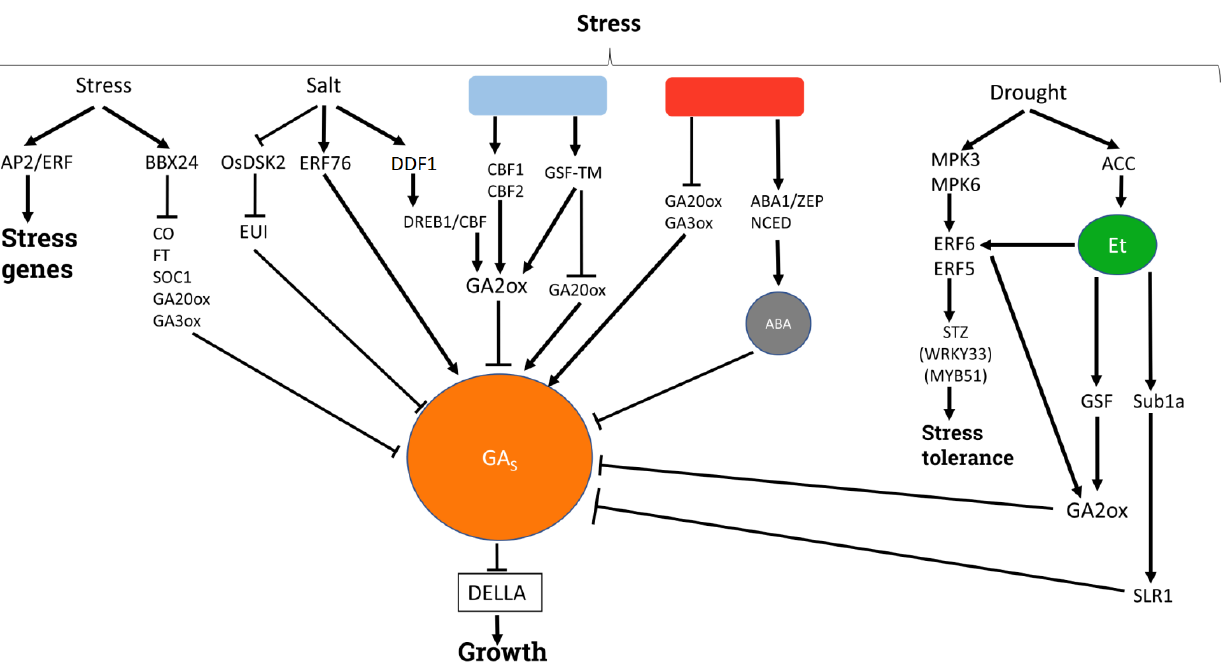
Figure 4. Schematic representation of the GA-related signaling involved in abiotic stress responses. Arrows indicate activation and blunt-end lines indicate repression or inhibition. Blue-box indicates cold stress, red-box indicates heat stress. See text for details and references. ABA: abscisic acid,